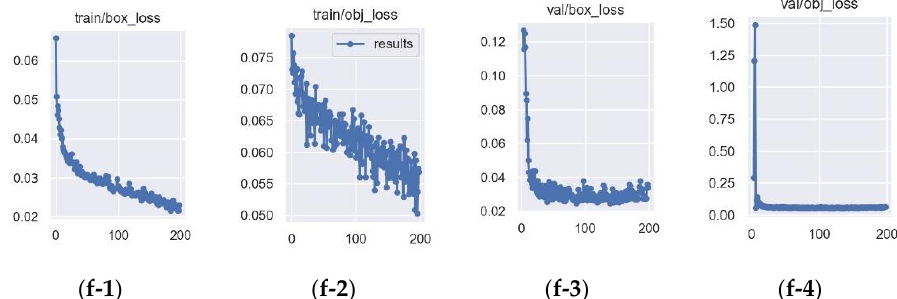
Figure 13. The changes of box_loss and obj_loss of different YOLOv5 models: ( a-1 ) train/box_loss of